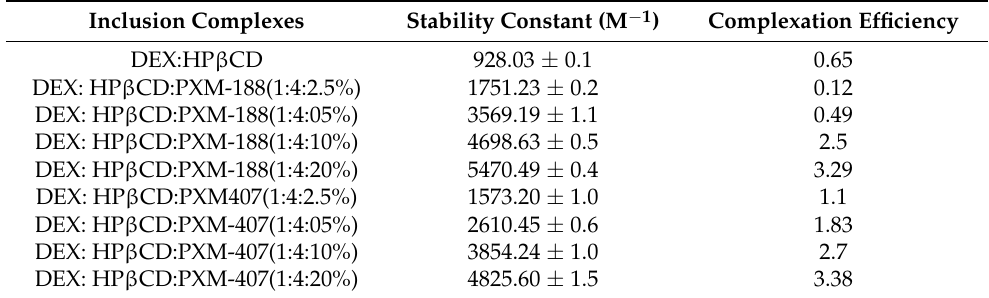
Table 2. Stability constant and complexation efficiency results of binary and ternary inclusion complexes.